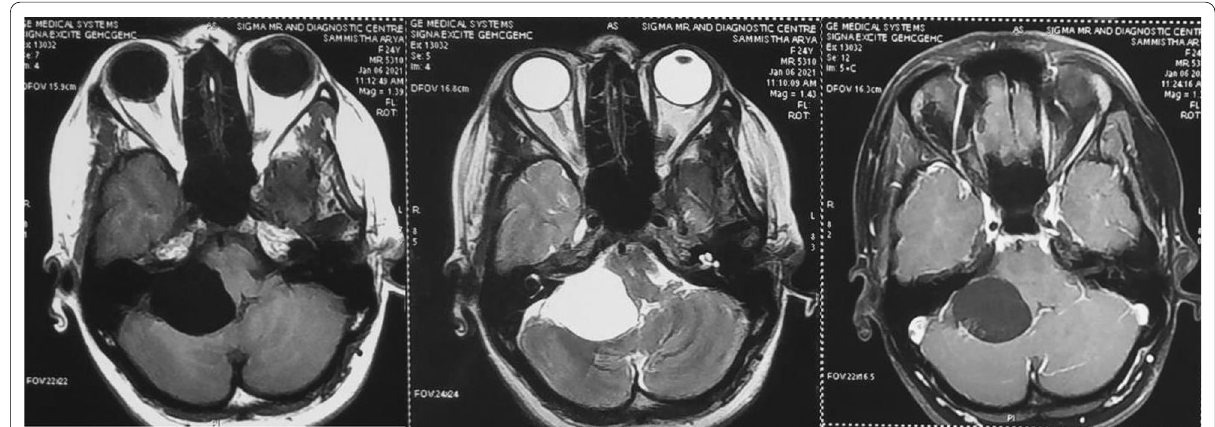
Fig. 1 Extra-axial cystic appearing lesion seen in the right CPA cistern. The mass is hypointense on T1, hyperintense on T2 with no contrast enhancement